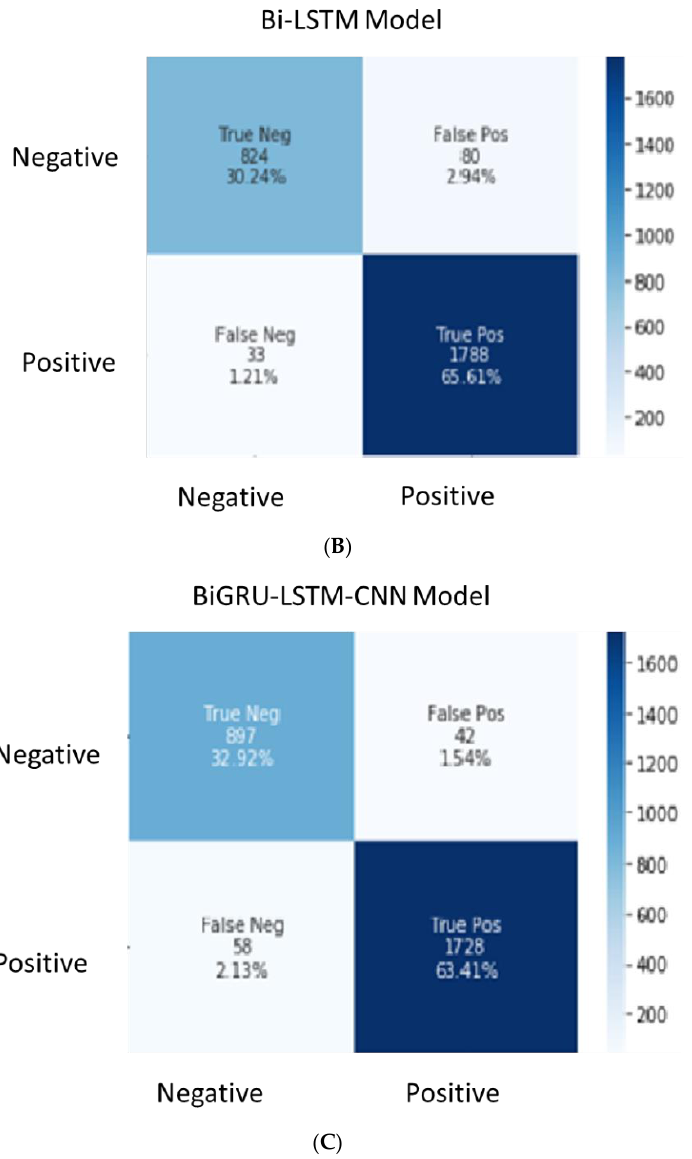
Figure 5. Confusion matrix of ( A ) LSTM; ( B ) Bi-LSTM; and ( C ) Bi-GRU-LSTM-CNN model. Table 2. Performance metrics-LSTM; Bi-LSTM; and Bi-GRU-LSTM-CNN